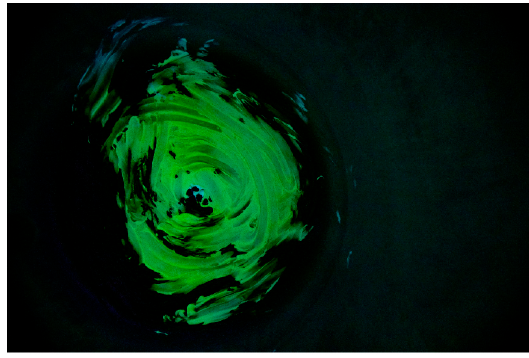
Figure 10. Subtracted image.